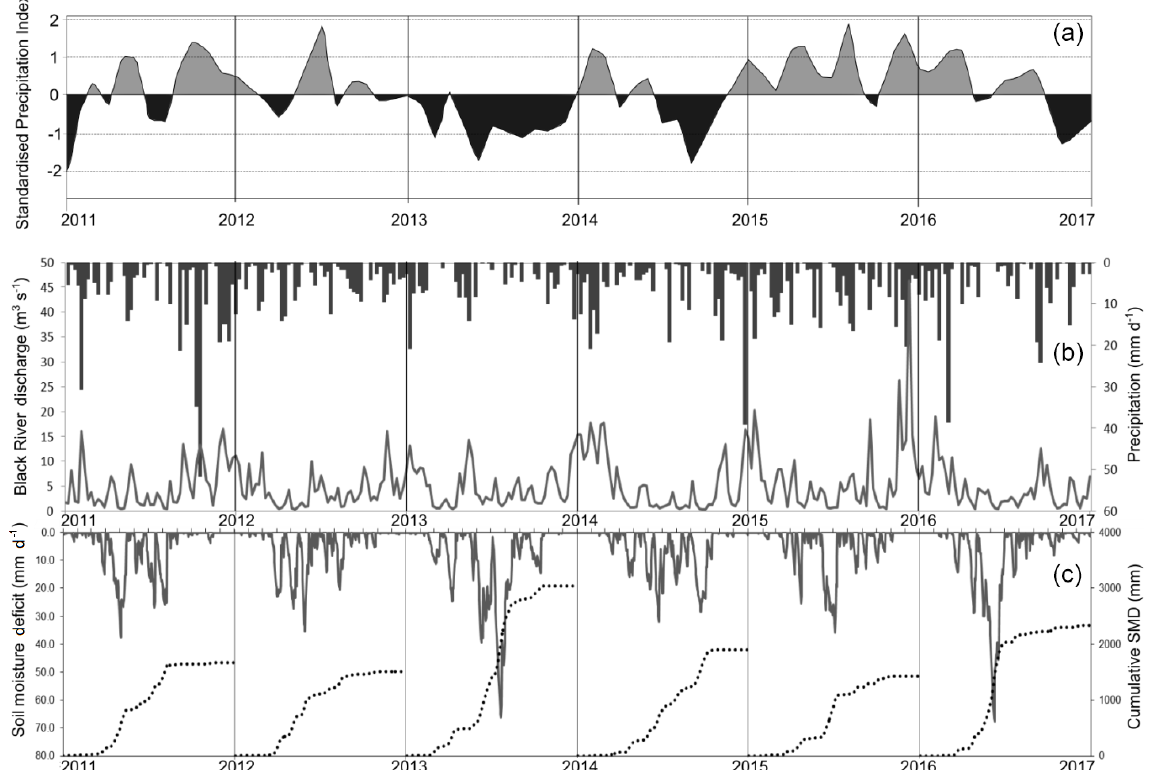
Figure 2. Panel (a) shows the 1-month Standardised Precipitation Index (SPI) calculated using precipitation data from the Newport climate station (reference period 1995 to 2010). Periods during which the index is >1 represent moderately wet conditions, and periods during which the index < − 1 indicate moderately dry conditions. (b) Black River discharge (grey line; m 3 s − 1 ) and mean precipitation (black bars; mmday − 1 ). (c) Cumulative soil moisture deficit (SMD) per year (mm; dotted line) and actual soil moisture deficit (mmday − 1 ; grey